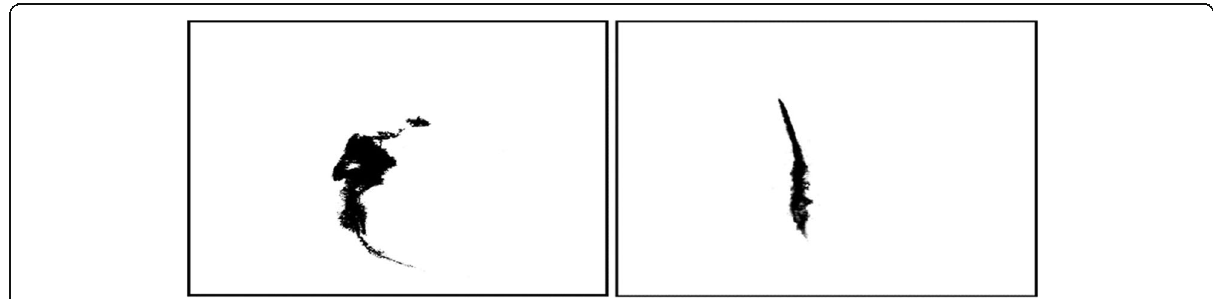
Fig. 9 Volcanic ash cloud segmentation results by the proposed method (the left is the April 19, 2010, image, and the right is the May 11, 2010,